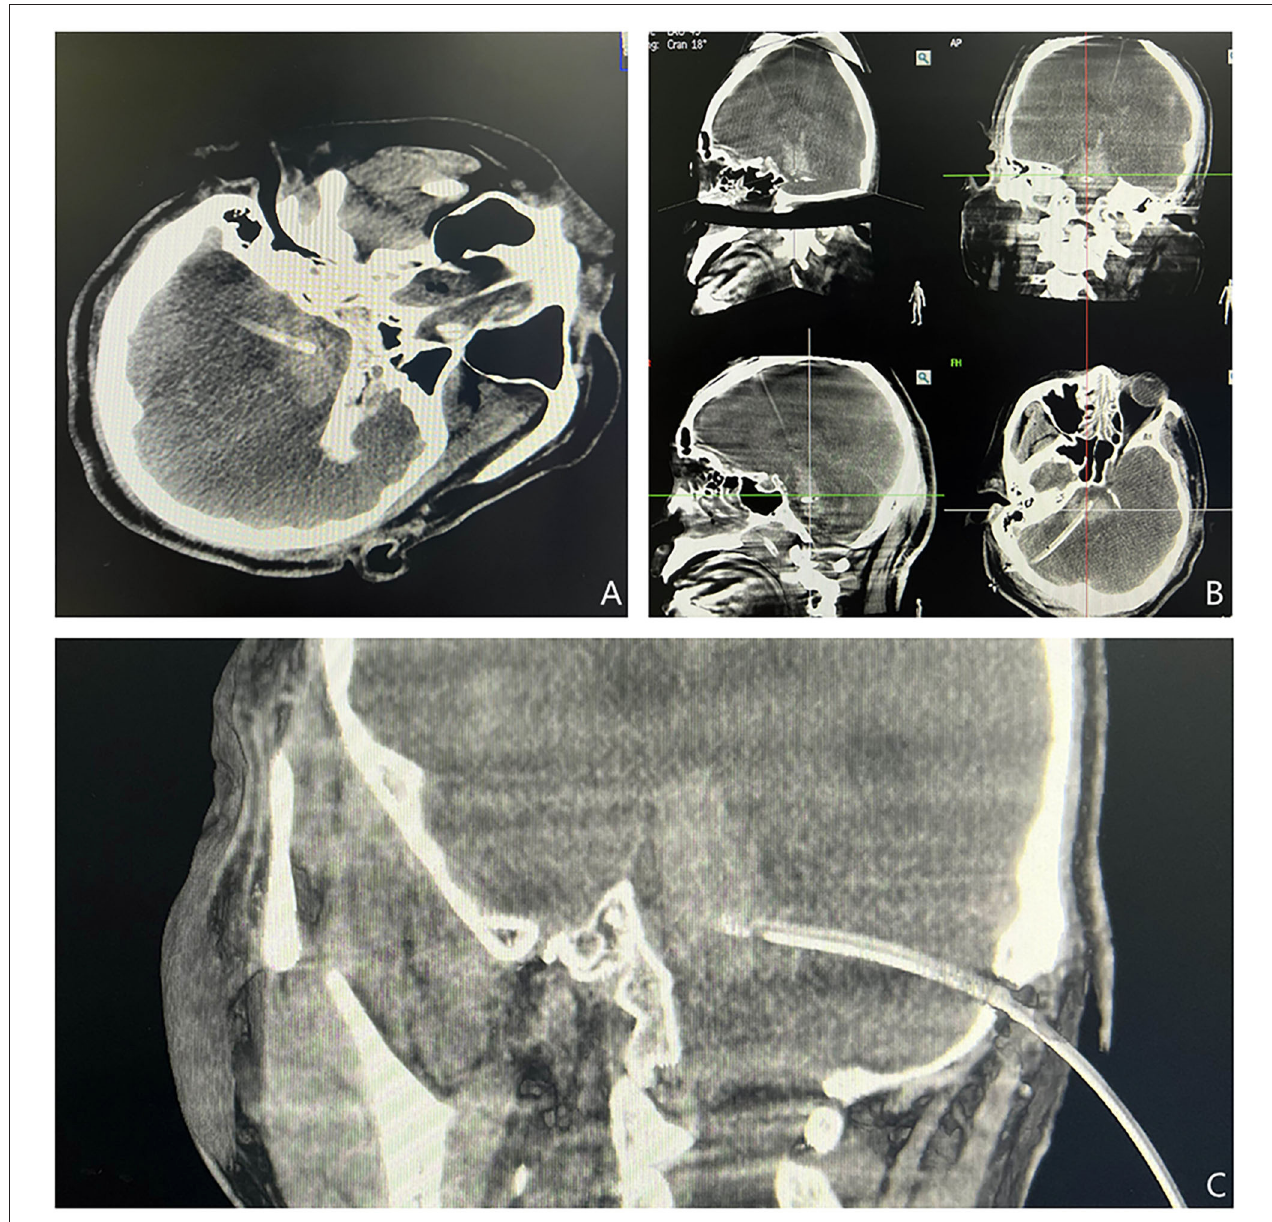
FIGURE 4 | (A–C) XperCT was performed again to determine the location of the drainage tube. The positions of the drainage tubes shown in the axial, coronal, and sagittal views were satisfactory.